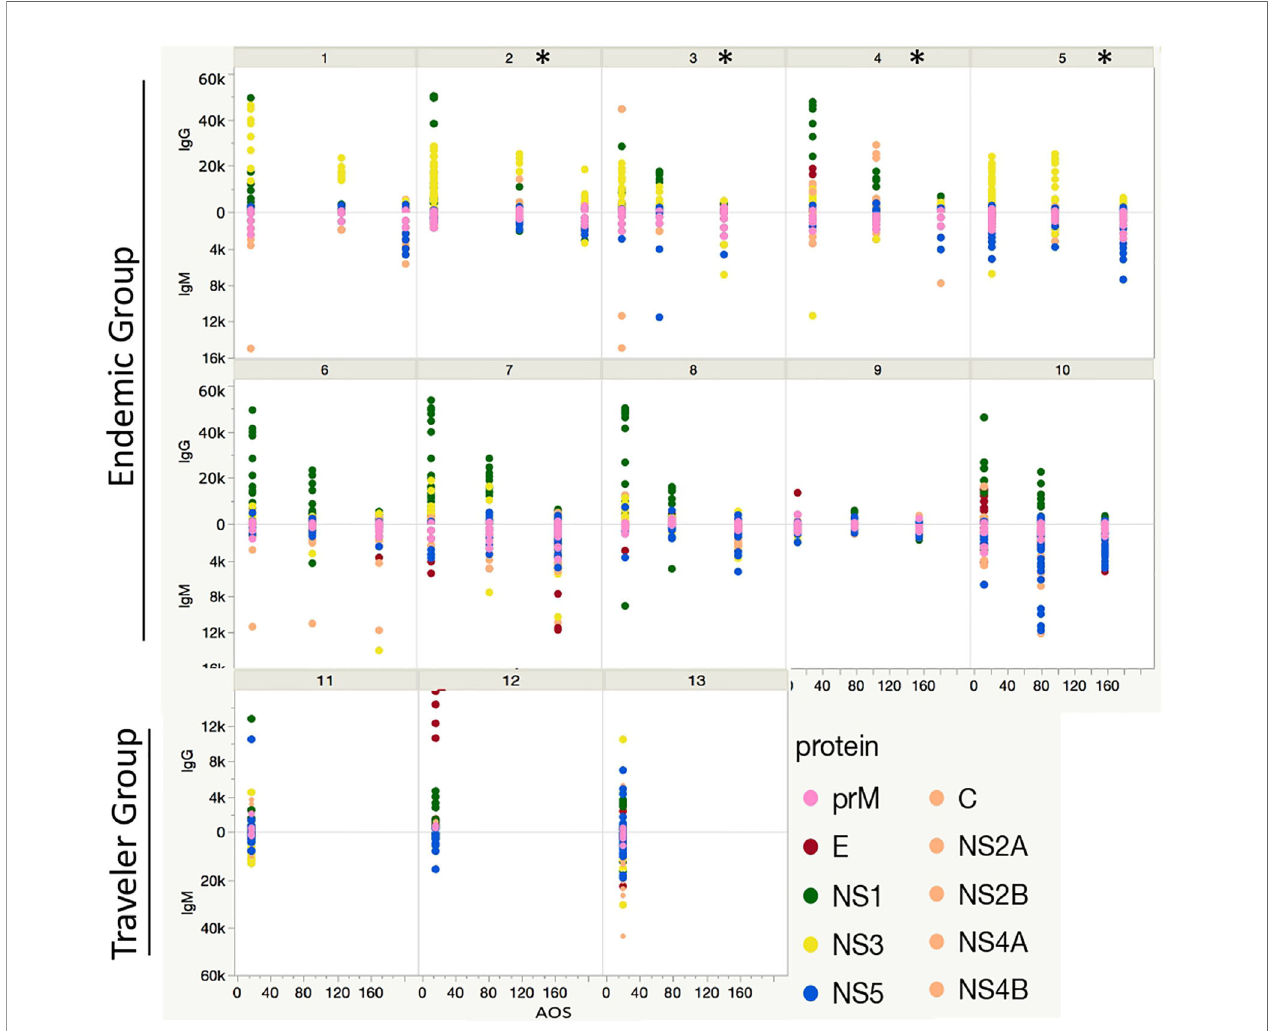
FIGURE 6 | Longitudinal humoral response to DENV proteins. Each box represents the individual response of each patient through time in the endemic (from 1 to 10) and traveler (11 - 13) groups. The y axis indicates the Ab fold change per patient at the early-, mid- and late-convalescent samples, relative to the acute sample, colored by protein target. The x axis indicates the days when the convalescent samples were collected. The * symbol refers to patients presenting severe symptoms of dengue and needed